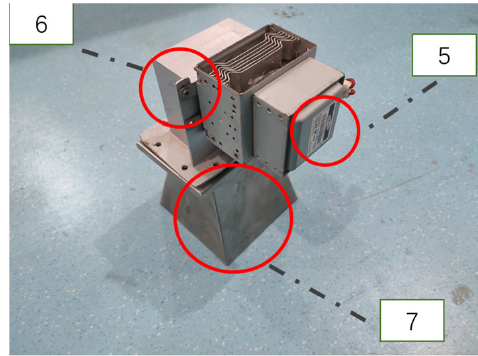
Figure 3. Microwave emission source unit.